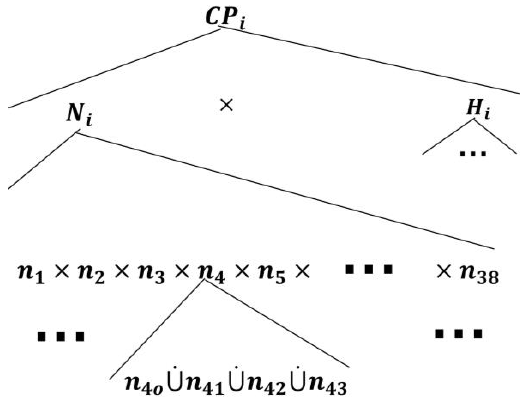
Figure 8. The 𝑴 𝒊 state space topology with the nursing station, 𝑵 𝒊 , expanded. Figure 8. The M